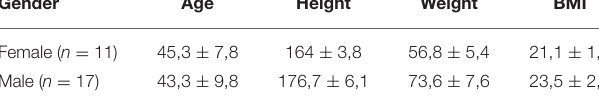
TABLE 1 | Baseline characteristics of the volunteer runners. Gender Age Height Weight BMI Female ( n = 11) 45,3 ± 7,8 164 ± 3,8 56,8 ± 5,4 21,1 ± 1,8 Male ( n = 17) 43,3 ± 9,8 176,7 ± 6,1 73,6 ± 7,6 23,5 ±